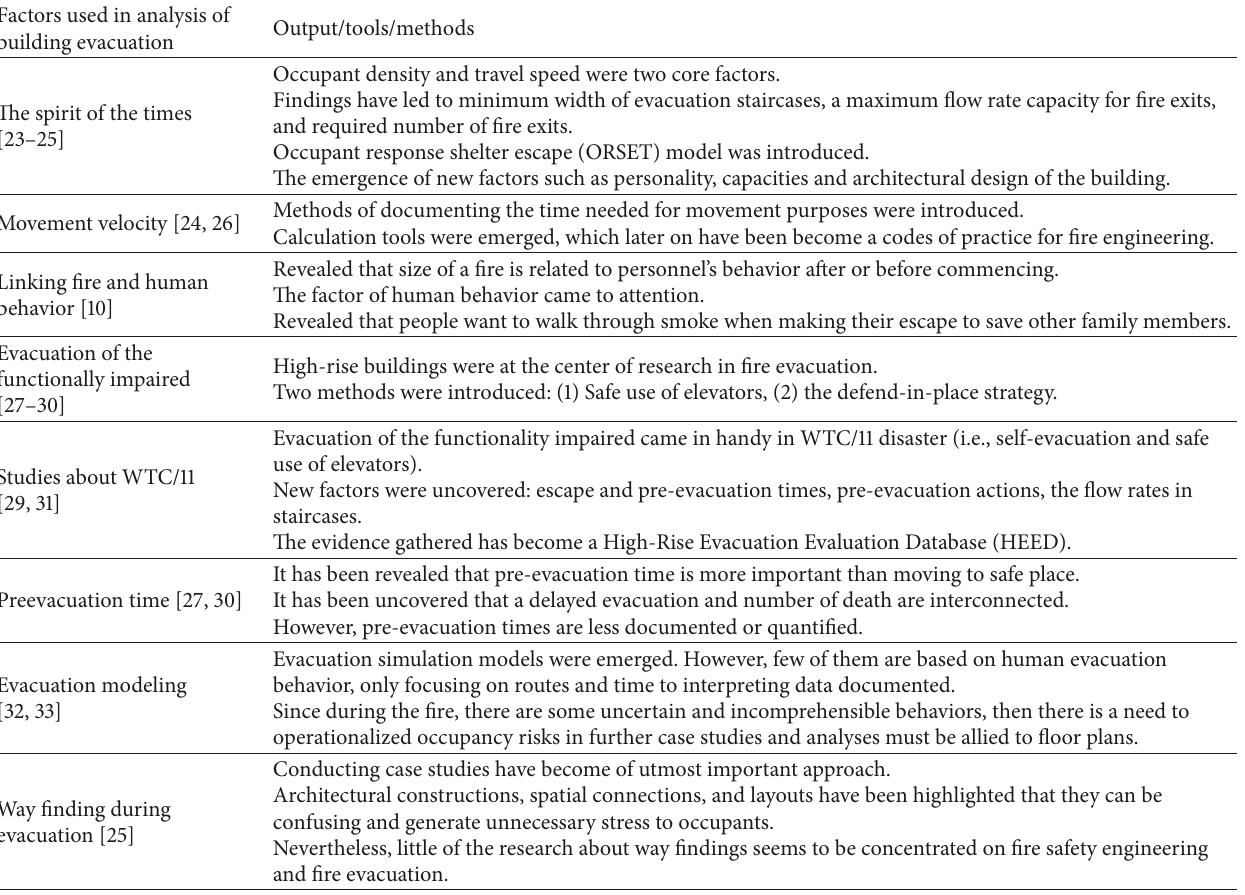
Table 1: Summative evaluation of the research into human behavior in a